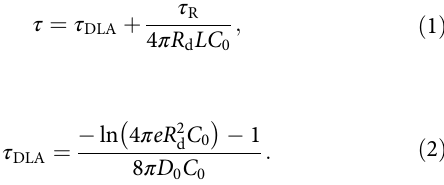
sticky-end DNA on their surfaces staying within the reaction region (thickness L ~ 10 nm). C 0 is the number density of droplets